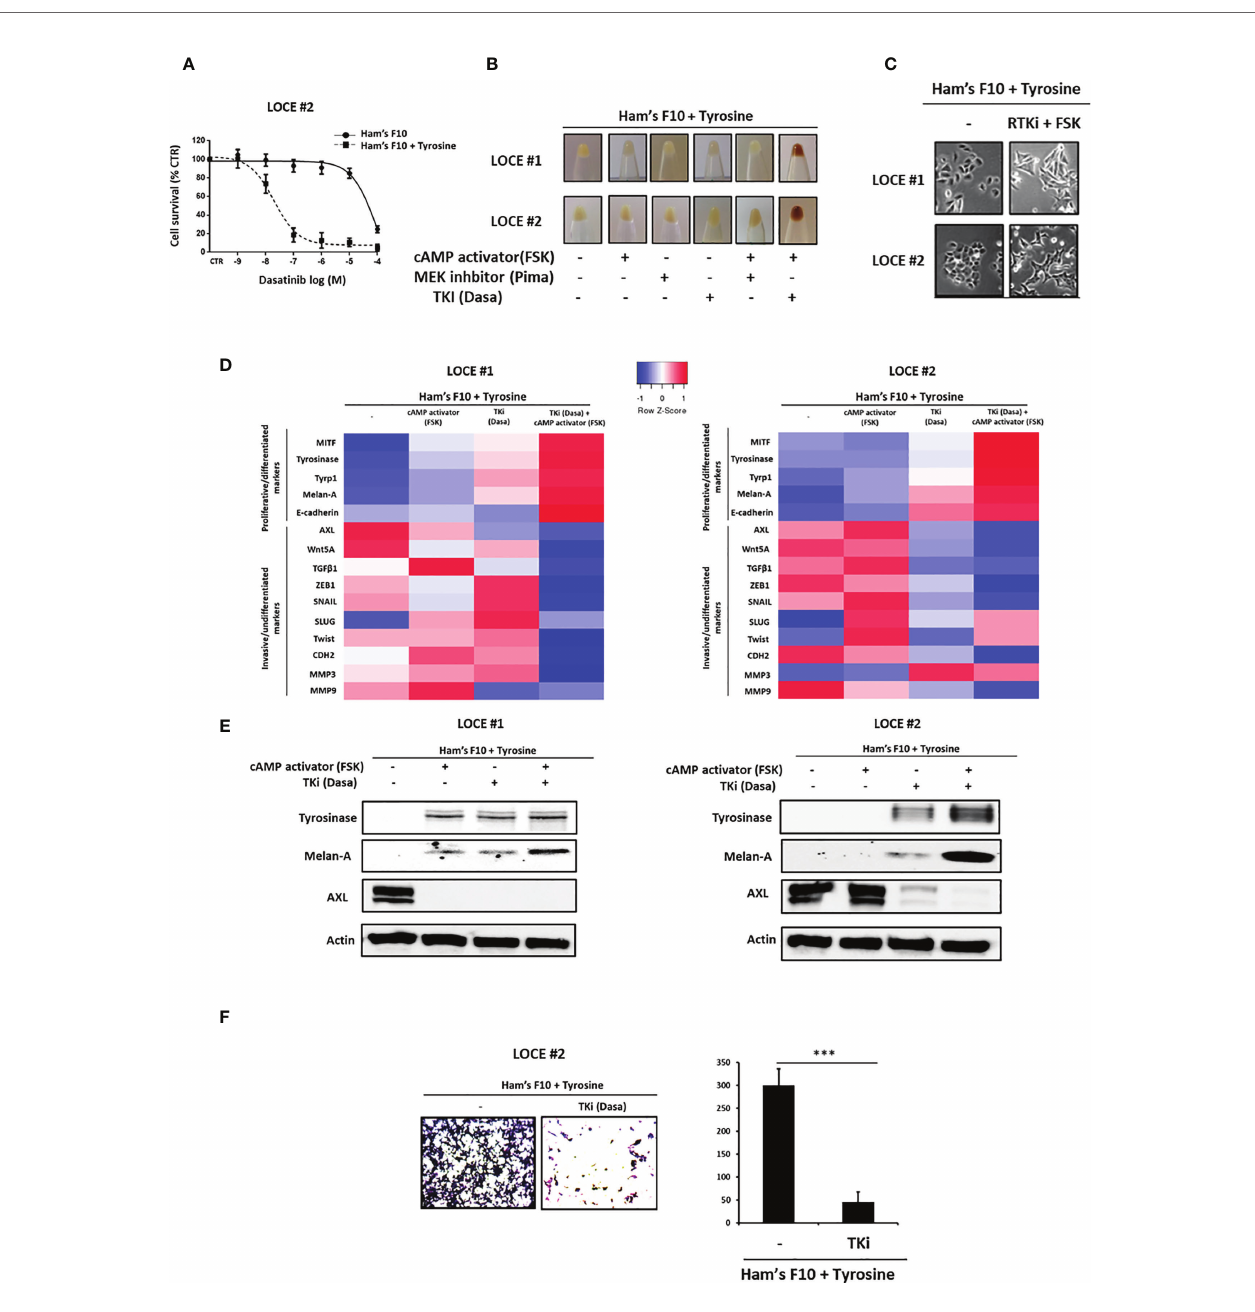
FIGURE 5 | Tyrosine-induced de-differentiation is reverted by Tyrosine kinase inhibitors (TKI). (A) Phenotype switching induced by tyrosine leads to marked sensitivity to TKI as showed in survival curves of switcher primary culture (LOCE #2) treated with Dasatinib for 72h and cultured in low versus high tyrosine concentrations. Data are shown as means Mean ± SEM (n=3) compared to untreated cells (control, CTR). (B – E) Restoring the pigmented phenotype. (B) Comparison of visible pigmentation of cell pellets from the two switcher primary cultures (LOCE #1 and 2) established in high tyrosine medium (Ham ’ s F10 supplemented with tyrosine) following 14 days after trying to restore pigmented phenotype in this medium by adding a cAMP activator (Forskolin) and different MAPK targeted agents (MEK or TKI inhibitors). (C) Comparison of cell morphology in high tyrosine medium (Ham ’ s F10 supplemented with tyrosine) in the presence or not of an RTK inhibitor (Dasatinib) and cAMP activator (Forskolin) for 14 days. (D, E) (D) Heatmap of gene expression levels (average signature Z scores) for representative genes of the differentiated and invasive states (rows) and (E) protein expression (representative western blot) of the most discriminative markers of the differentiated (tyrosinase and melanA) and the invasive (AXL) phenotypes within the switcher primary cultures (LOCE # 1 + tyrosine and LOCE # 2 + tyrosine) established in high tyrosine medium after 14 days with an RTK inhibitor (Dasatinib), cAMP activator (Forskolin) either alone or in combination. (F) Effect of TKI (Dasatinib) on cell migration activity induced by tyrosine in primary culture (LOCE #2 + tyrosine). left panel shows representative regions of the chamber fi lters with crystal violet-stained cells. Right panel indicates the number of migrated cells per fi eld calculated from three independent experiments. Data are presented as Mean±SEM, n=3 (***p < 0.001,